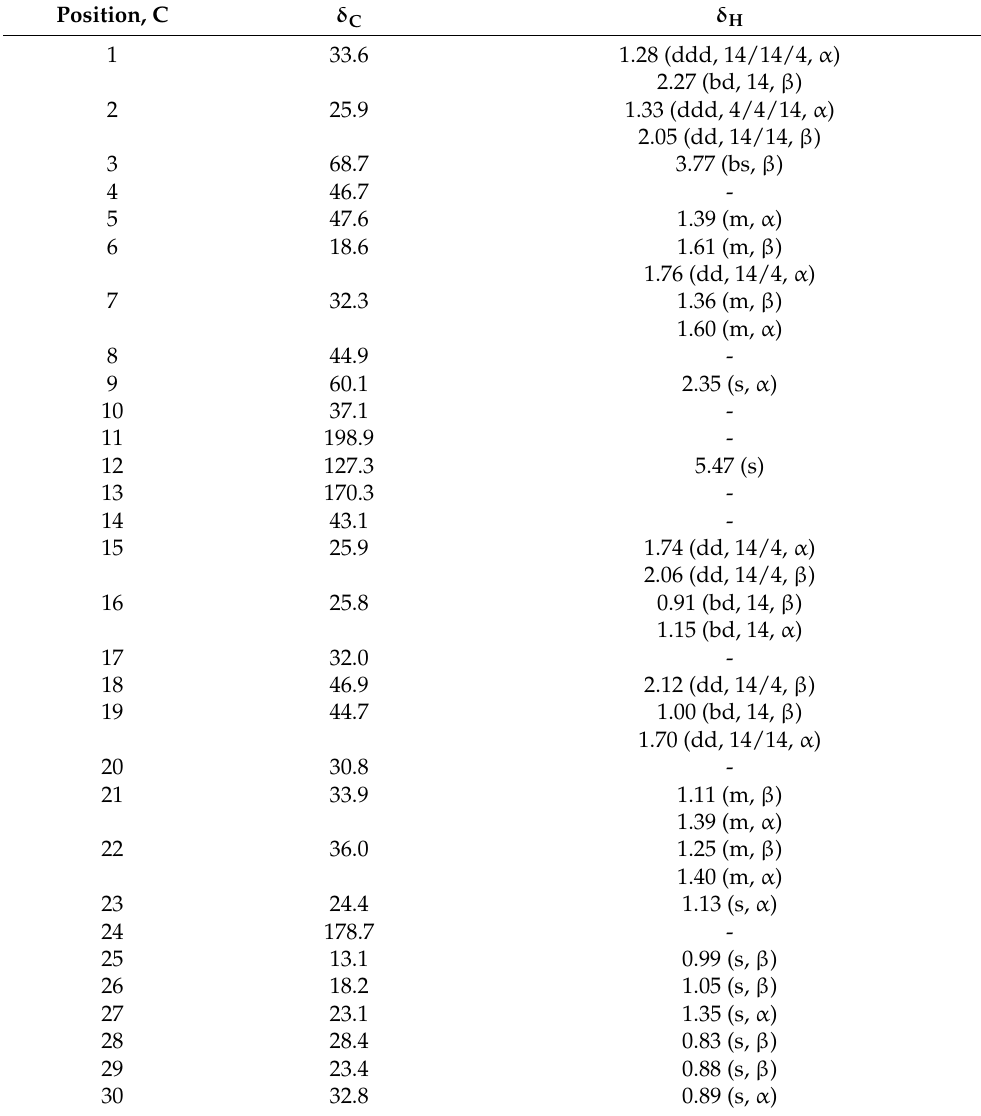
Table 1. 1 H and 13 C NMR (proton and carbon-13 nuclear magnetic resonance) assignments for 11-keto- α -boswellic acid ( α -KBA) in DMSO- d 6 (deuterated dimethyl sulfoxide). Chemical shifts 3 J δ δ H / C in ppm (multiplicity, HH in Hz,